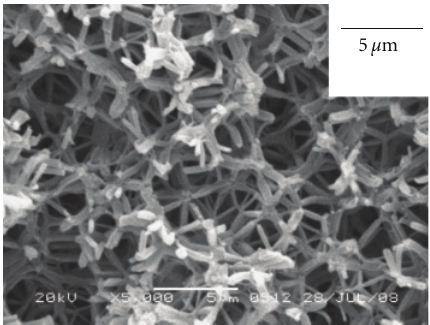
Figure 1: SEM image of the ME-EvD